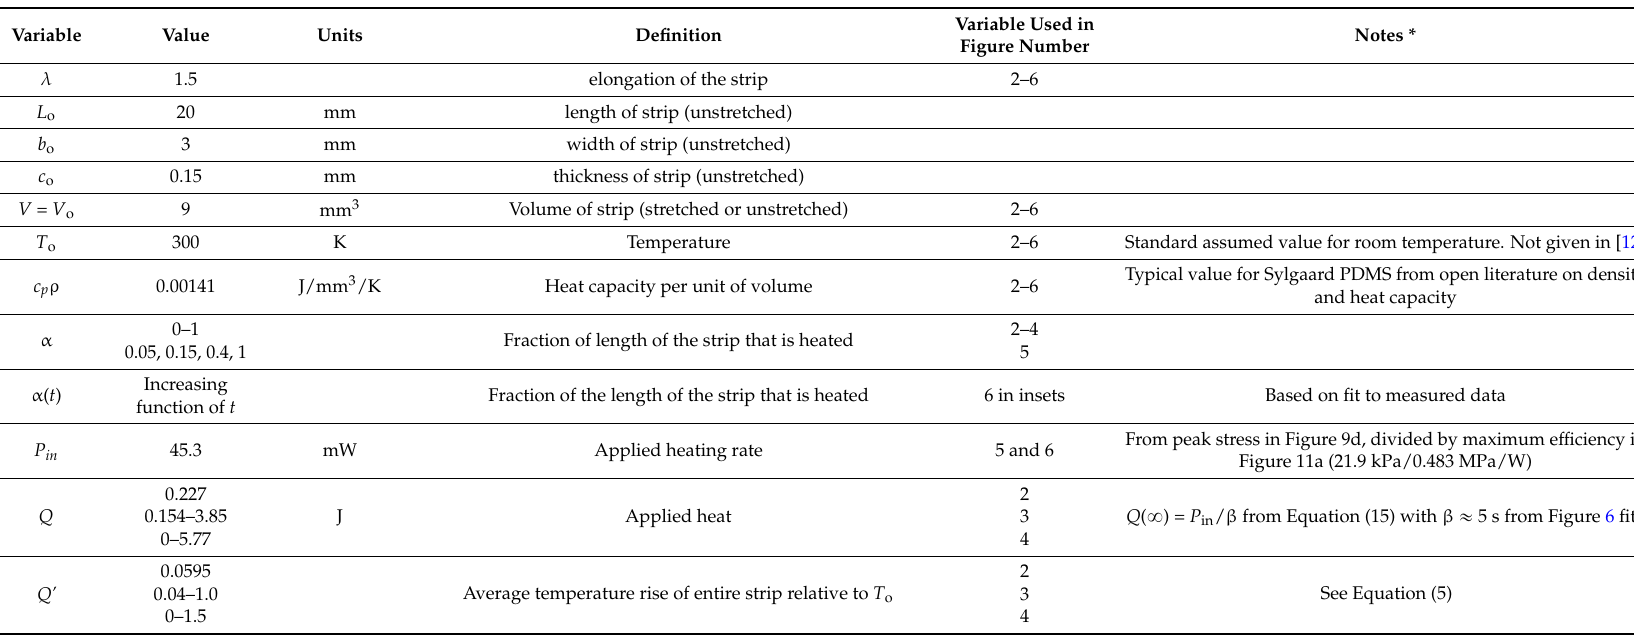
Table A1. The table below summarizes the material constants and other parameters used in the plots of Figures 2–6. The values were chosen that provide a reasonably close correspondence with the experiments reported in